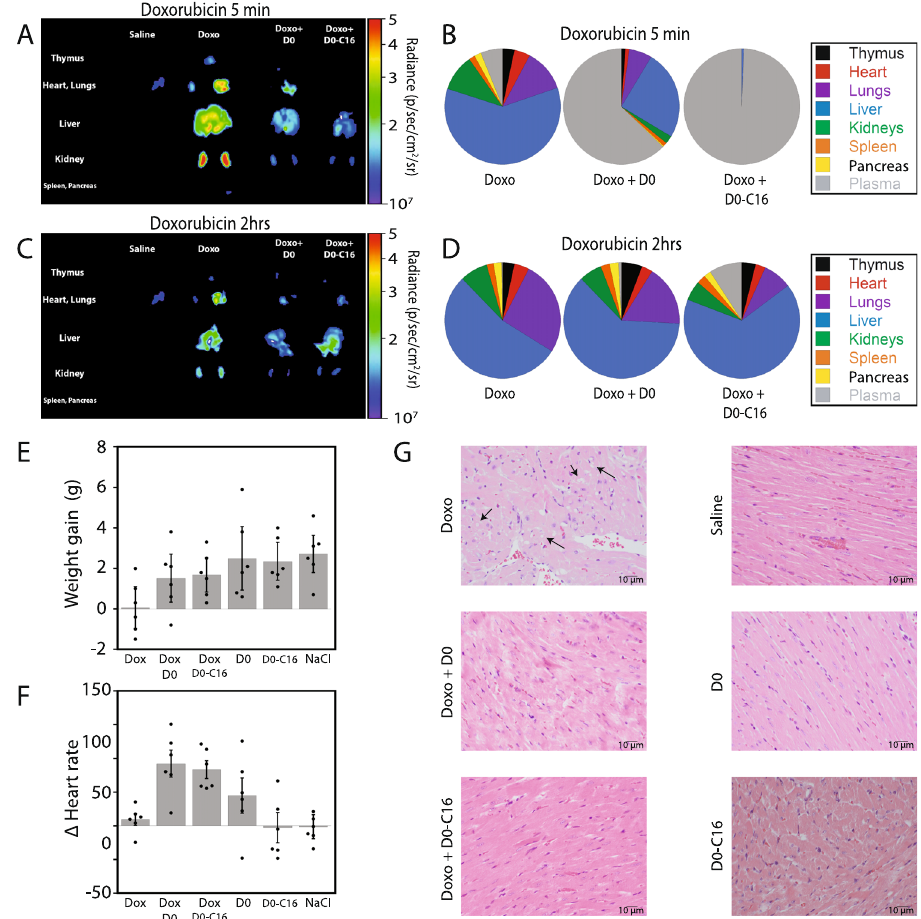
Fig. 6 | Molecular buffers enable the programming of the biodistribution of a drug.A – D Exvivobioimagingof10mg/kgdoxorubicinformulationsinIV-injected CD-1 female mice with n =3. The formulations 0.9-D0- L -thioate (see D0 in the fi g- ure) and 0.9-D0- L -thioate-C16 (see D0-C16 in the fi gure) were programmed to maintain a free concentration of doxorubicin of 5 µ M. The percentage of doxor- ubicin in each organ/serum was determined using fl uorescence imaging for the organsandHPLCfortheserum. E , F WeightgainsandchangesinheartrateinCD-1